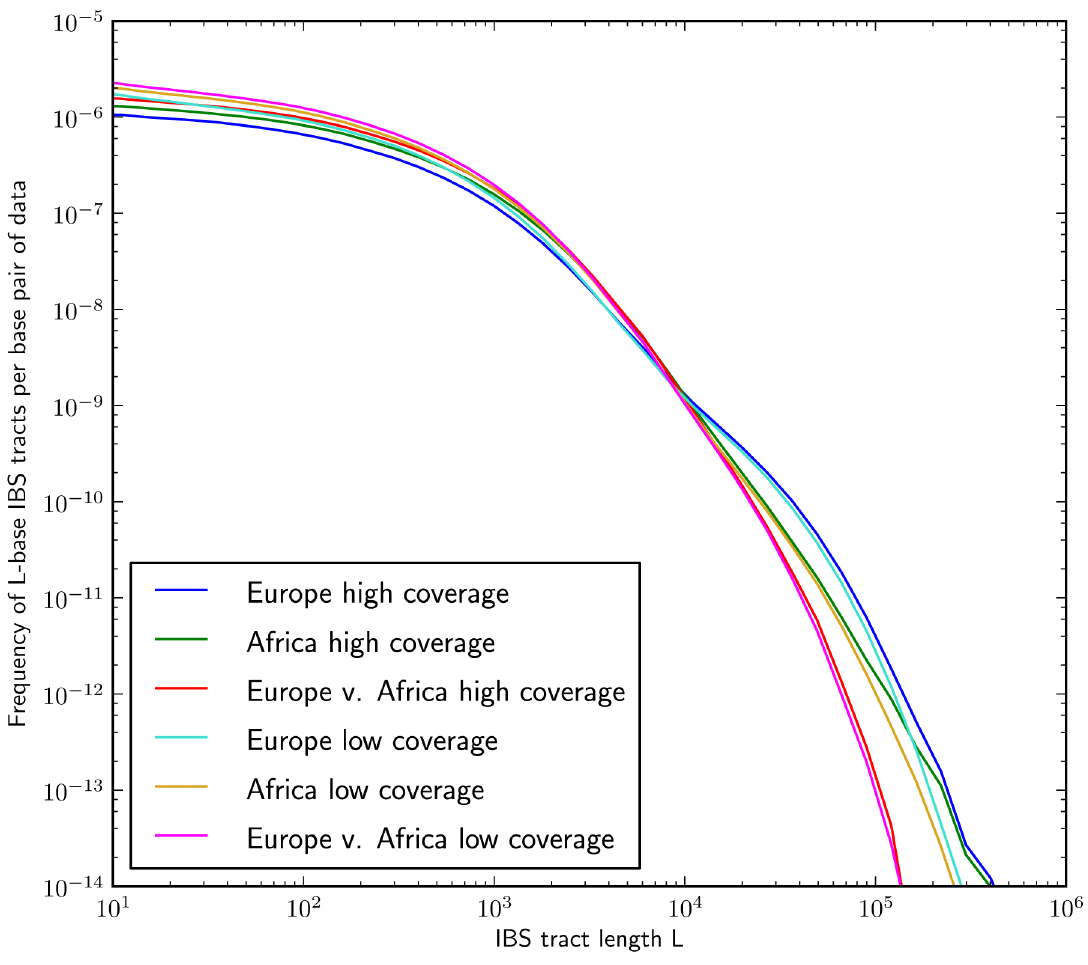
Figure 5. IBS tract lengths in the 1000 Genomes pilot data: trios v. low coverage. These IBS tract spectra were generated from pairwise alignments of the 1000 Genomes high coverage trio parental haplotypes and the CEU (European) and YRI (Yoruban) low coverage haplotypes, aligning samples within each population and between the two populations. Due to excess sequencing and phasing errors, the low coverage alignments have excess closely spaced SNPs and too few long shared IBS tracts. Despite this, frequencies of tracts between 1 and 100 kB are very similar between the two datasets and diagnostic of population identity.